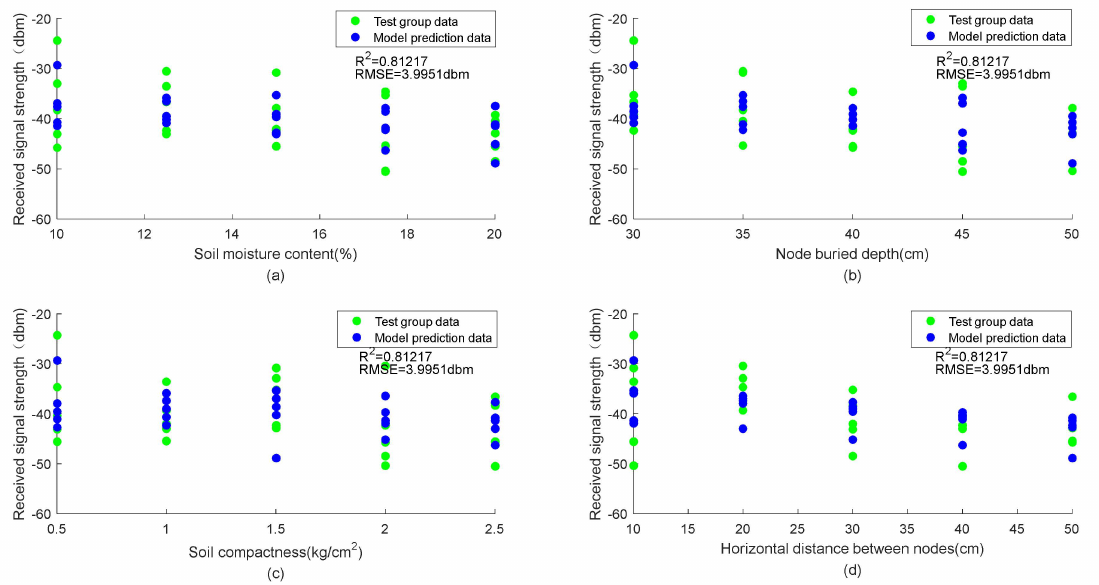
Figure 9. ( a – d ) Comparison between predicted results and test